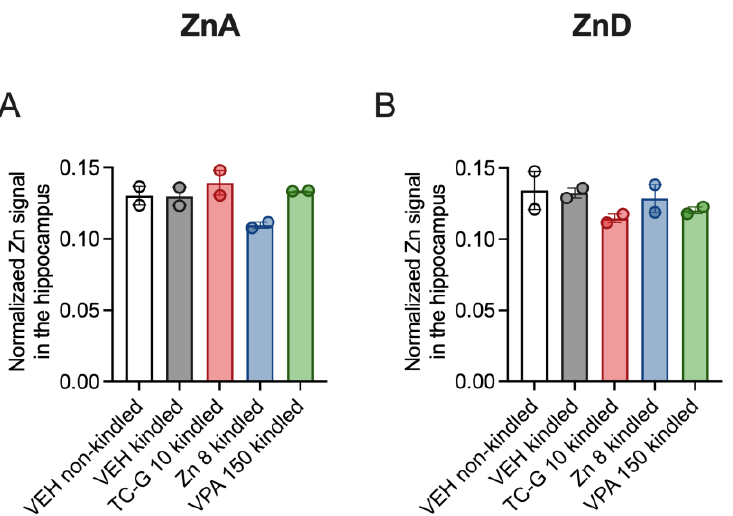
Figure 6. Chronic effects of TC-G 1008 (TC-G) (10 mg/kg), ZnCl 2 (8 mg Zn/kg), or VPA (150 mg/kg) and PTZ-kindling model of epilepsy on total zinc concentration in the hippocampi of mice fed the ZnA ( A ) or ZnD ( B ) diet. Brain samples were obtained 24 after the last injection of PTZ. Total zinc concentration was measured in hippocampal coronal sections using Inductively Coupled Plasma Mass Spectrometry (ICP-MS). Data are presented as means ± SEM of three replicates per mouse brain. Measurements for 2 brains per group are shown.